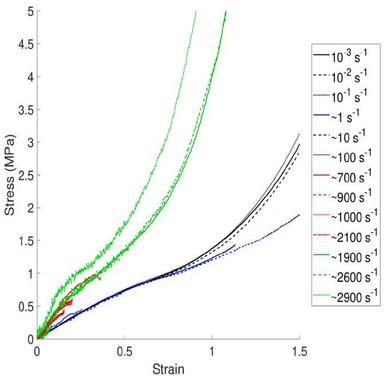
Varying strain rate data at 25 ◦C for U-NR.